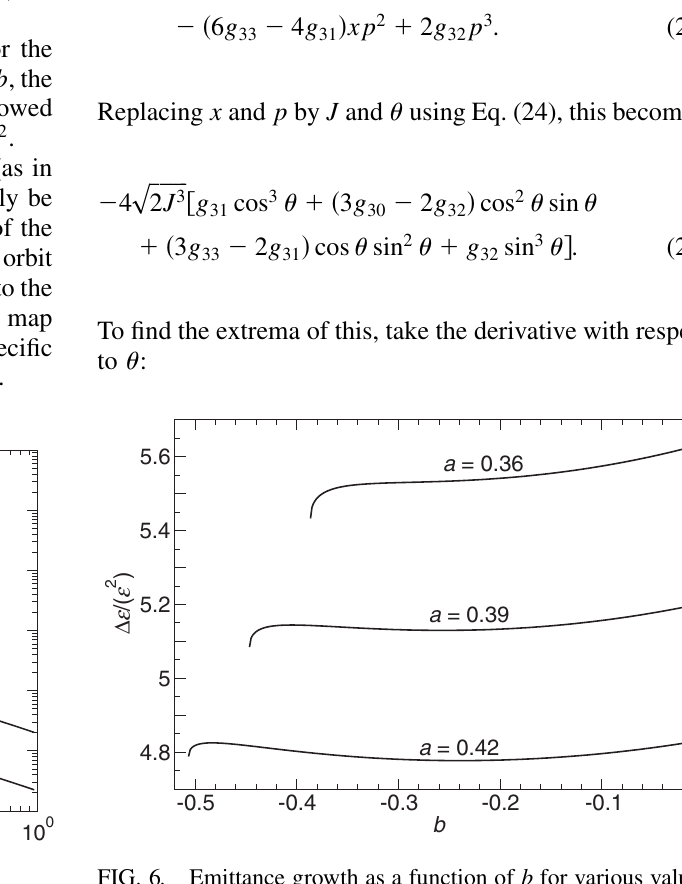
FIG. 4. Emittance growth, minimized over b and A . " is h J i .